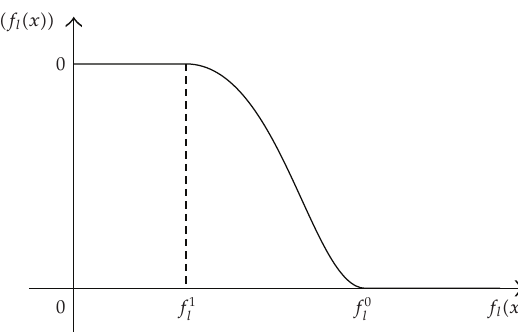
Figure 1: An example of membership